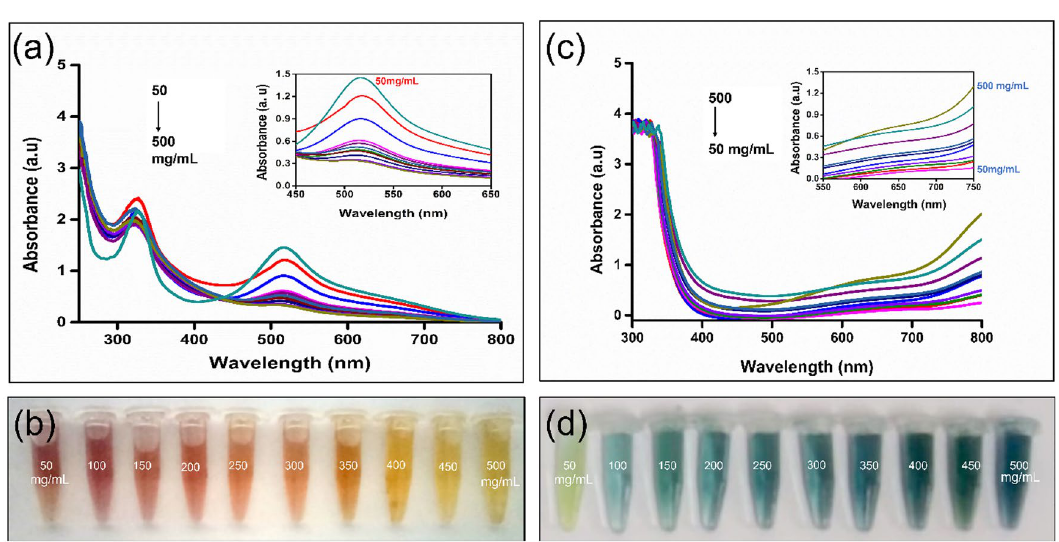
Figure 3. Antioxidant activity of CDs ( a ) DPPH free radical scavenging property of CDs ( b ) optical images of DPPH solution showing a gradual colour change (wine red to yellow) with the concentration increase of CDs ( c ) TAC activity by Phosphomolybdate assay ( d ) optical images of the TAC activity showing a gradual colour change (light green to deep greenish-blue) with the concentration raise of